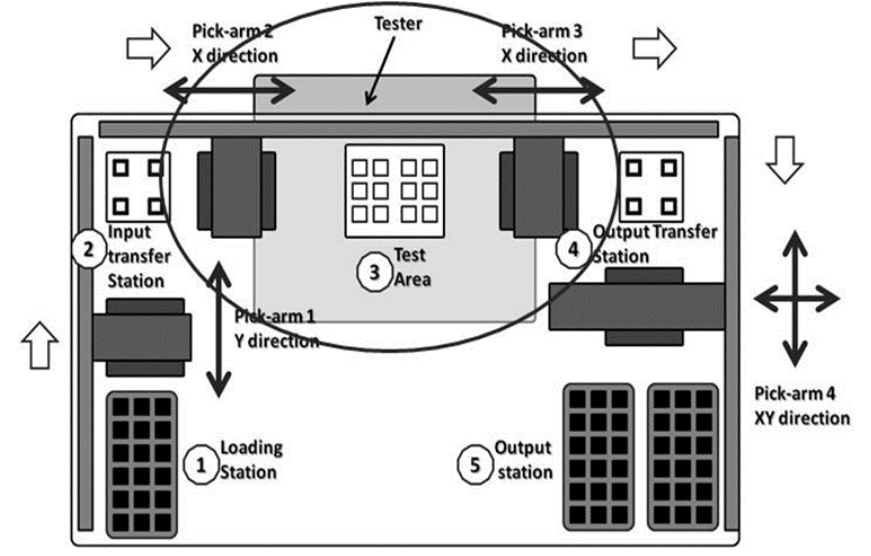
Fig. 4. Focus Area of the